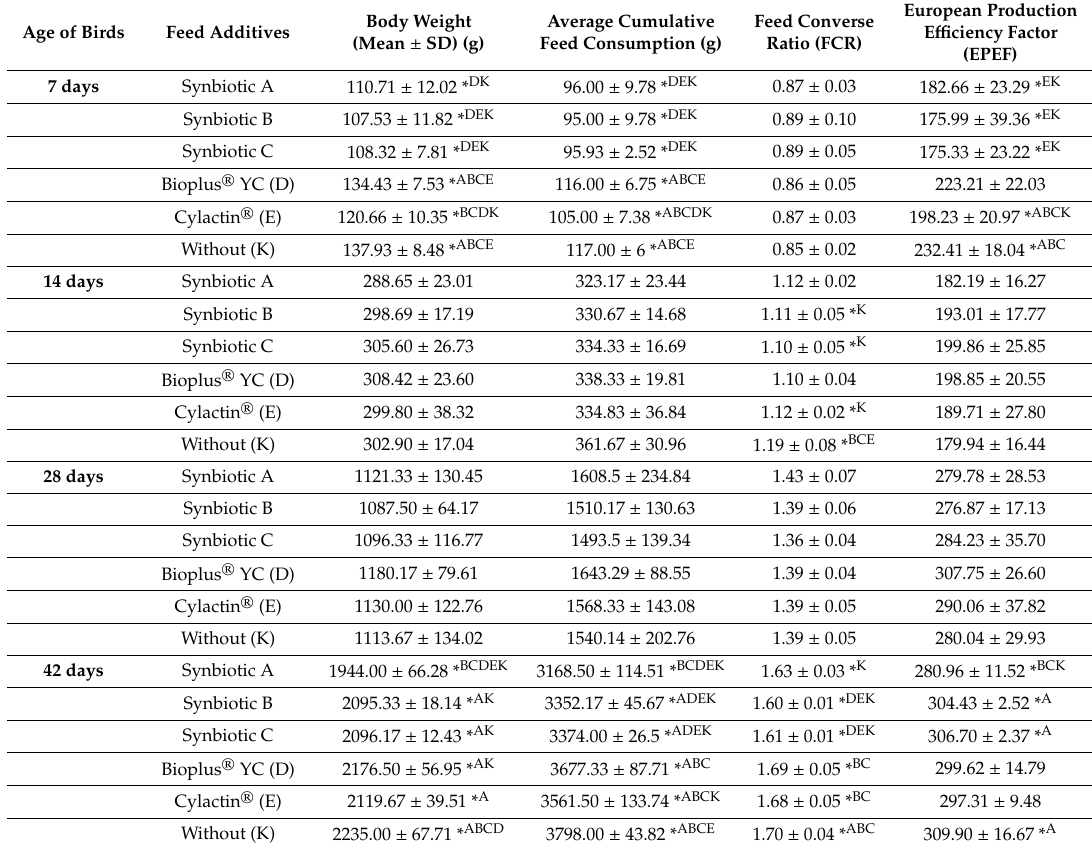
Table 3. Production parameters of chickens fed with the synbiotic- or probiotic-supplemented feed from the following sampling time points: 7, 14, 28 and 42 days of chicken life. *—statistically significant di ff erences between groups, p ≤